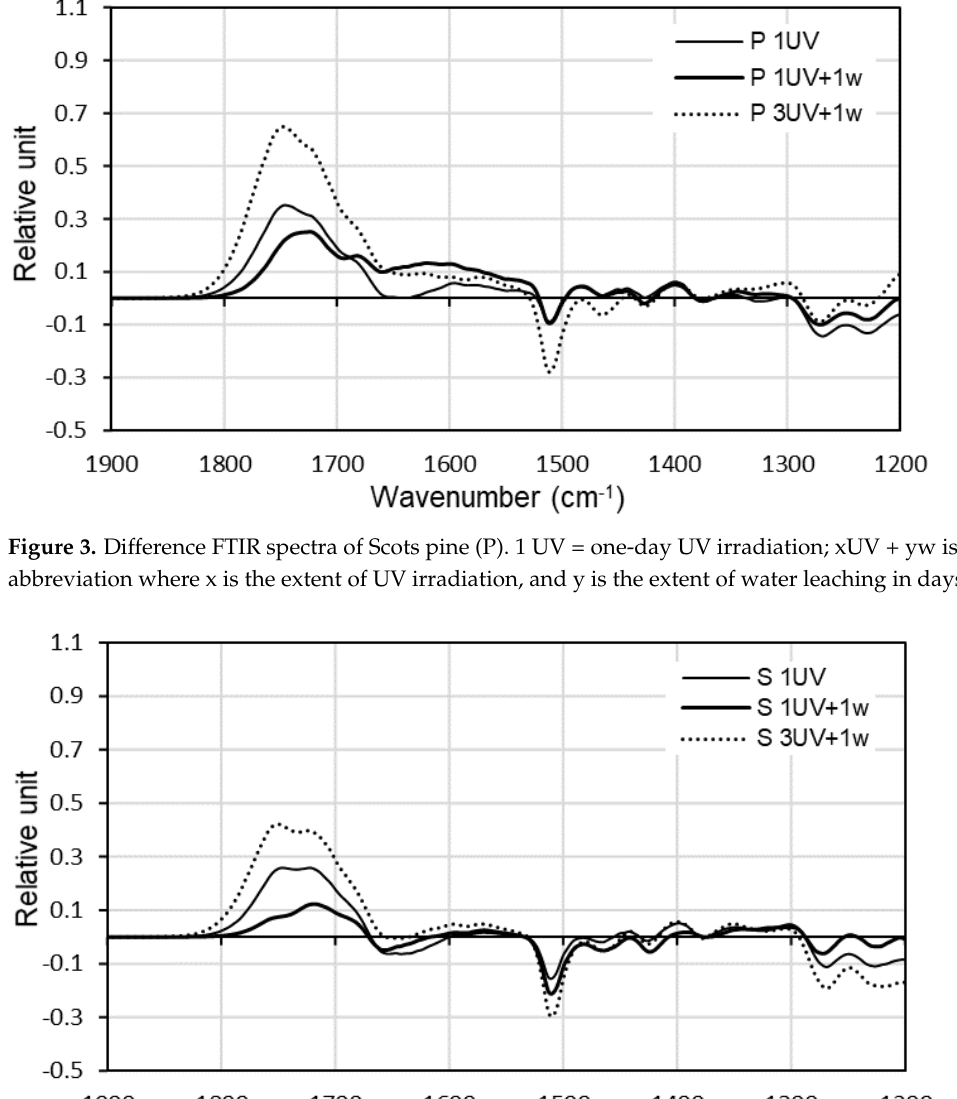
for spruce. Spruce samples presented greater absorption decrease than Scots pine samples in the whole unconjugated carbonyl region caused by water leaching. The two-day UV irradiation (after water leaching) created further lignin degradation and unconjugated carbonyl group production, presented by negative absorption increase at 1510 cm −1 and positive absorption increase between 1650 and 1820 cm −1 . Scots pine showed greater